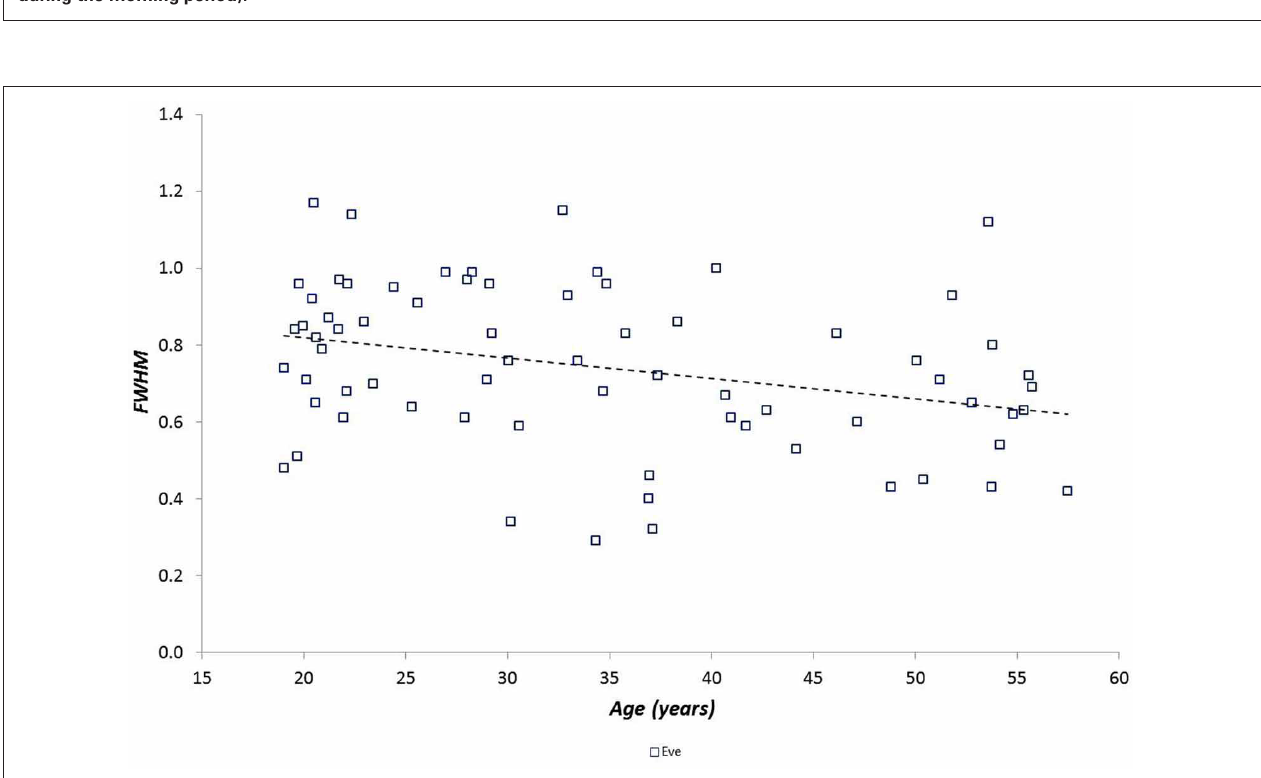
FIGURE 5 | Spectral width (FWHM) as a function of participant age during the Evening period (there was no relationship between h ∗ and age for the other periods).